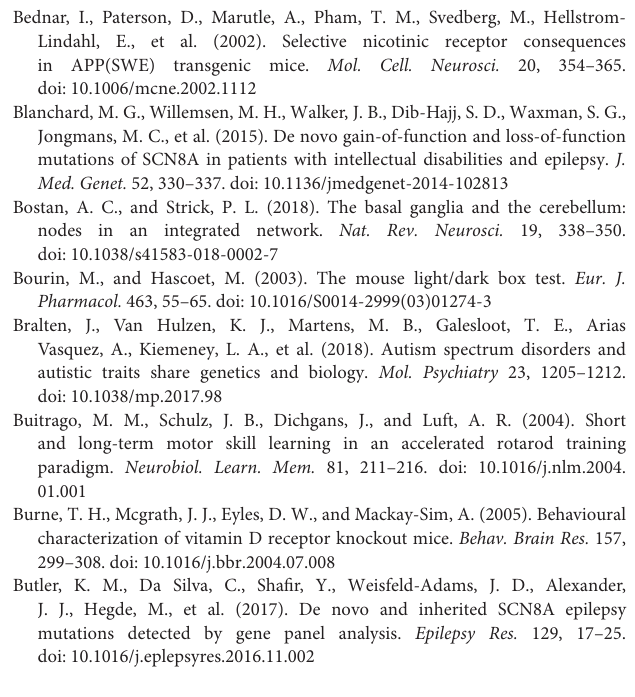
Supplementary Figure S1 | Sagittal cryosection of cerebellar Nav1.6 staining (green) and calbindin staining (red) showing the deficiency of Nav1.6 expression in PC of the Scn8a mutant mice. Nav1.6 staining in control Purkinje cells are indicated by yellow arrows. Scale bar 50 µ m. Supplementary Figure S2 | Scattered calbindin staining in the granule cell layer along the proximal segment of PC axons of Purkinje Scn8a mutant mice (arrows). Scale bar 100 µ m. Supplementary Figure S3 | Reduced excitability of Scn8a mutant PCs. (A,B) The evoked action potential in control and Scn8a mutant PCs in response to depolarization of 200pA. (C) Comparison of the mean frequency of repetitive firing at command potentials ( n = 10 for both control and Scn8a mutant groups. All data were presented as mean ± SEM, ∗∗∗ P < 0.001). Supplementary Figure S4 | Motor coordination and motor learning assessed on an accelerating rotarod. PC Scn8a mutants displayed decreased time on an accelerating rotarod and no improvement with training (Control: n = 9, Mutant: n = 11. P < 0.001, two-way ANOVA, Bonferroni’s post-hoc